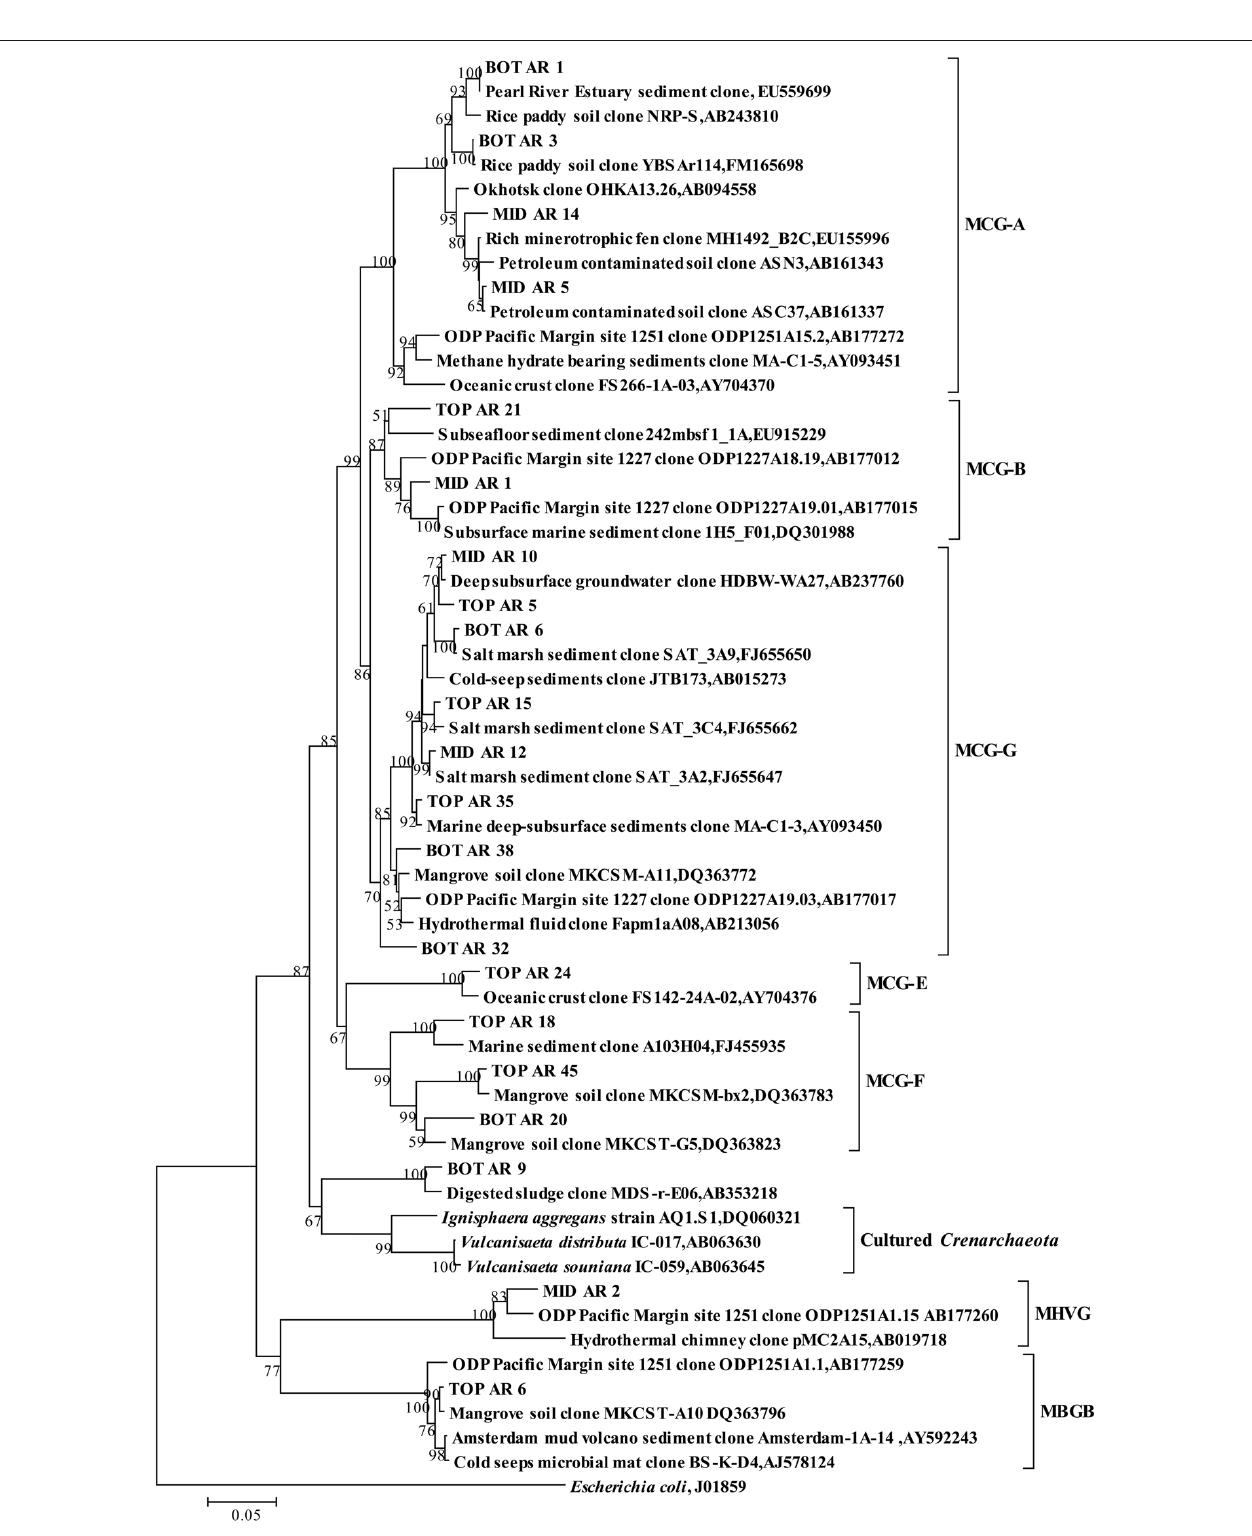
FIGURE A3 | Phylogenetic tree showing the affiliations of crenarchaeal RT-PCR products of 16S rRNA sequences retrieved from this study with selected reference sequences. The clones from the top, middle and bottom layers are differentiated as TOP, MID, and BOT, respectively. The tree was constructed by the neighbor-joining, using nearly full-length aligned